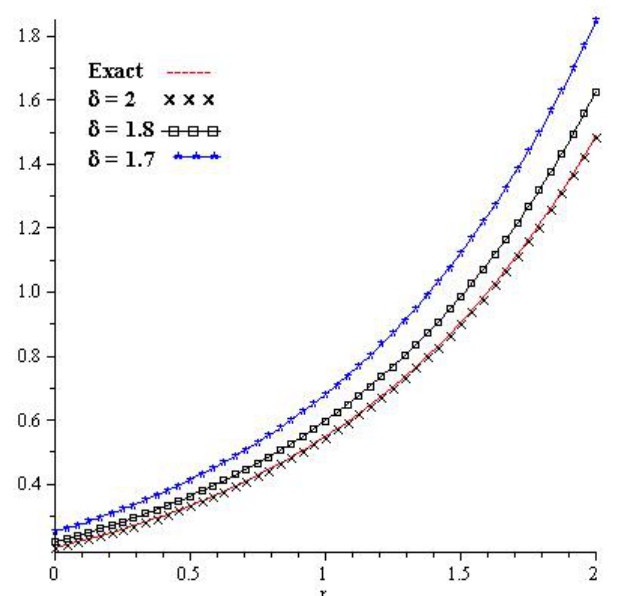
Figure 2. Natural transformation decomposition method (NTDM) solution of Example 1 at different fractional-order δ = 2,1.8,1.7.